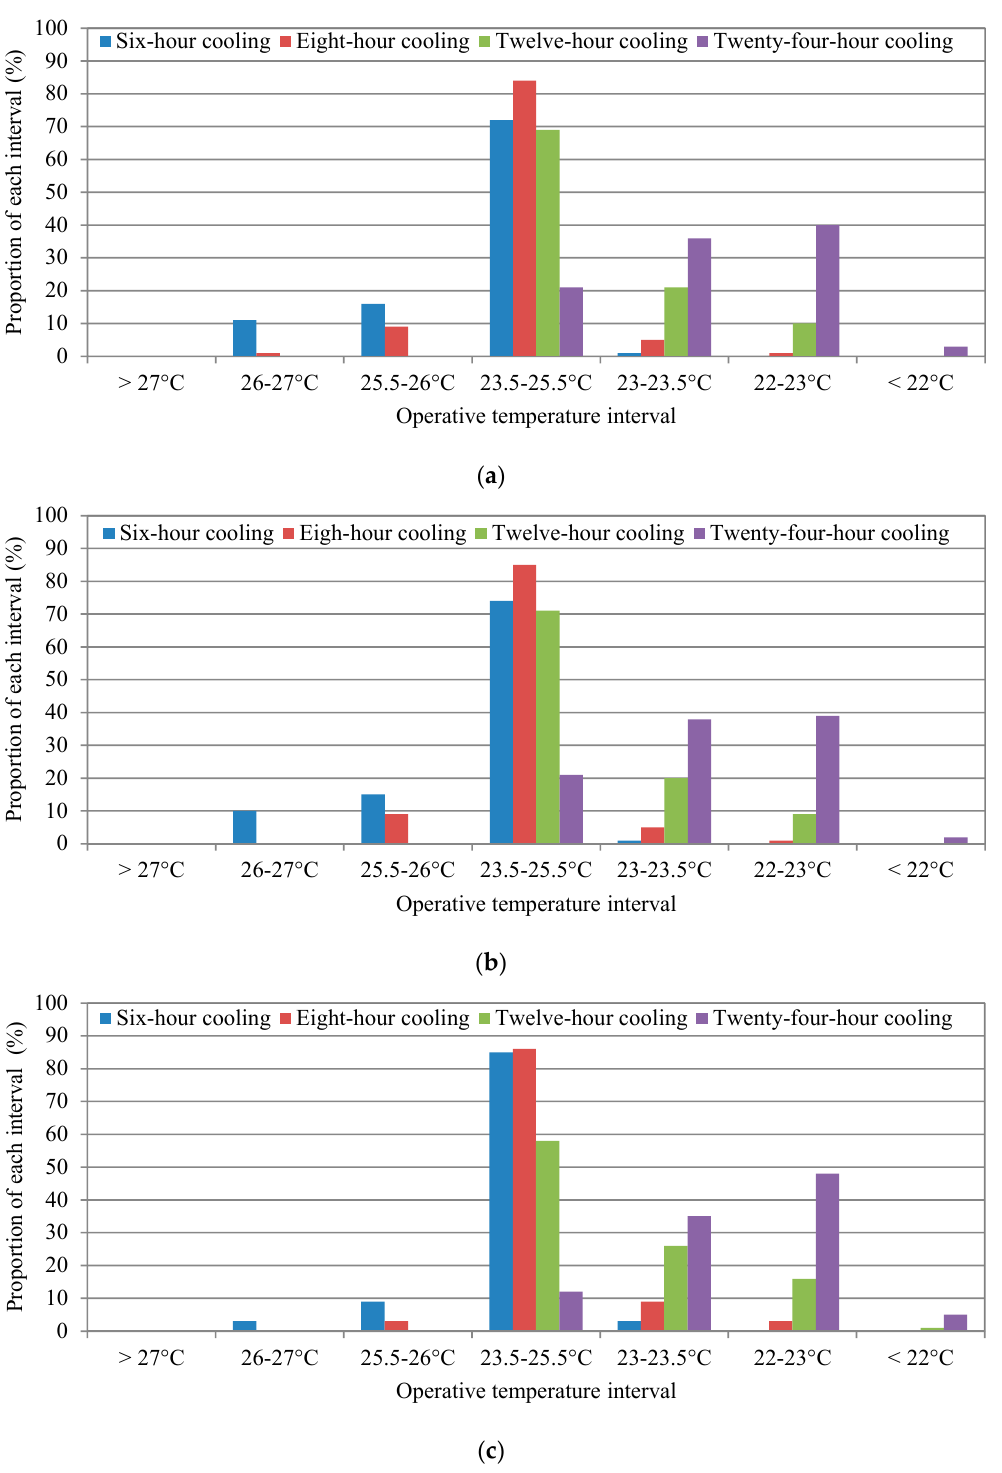
Figure 10. Proportions of time that different operative temperature intervals occur throughout the entire period of cooling under various cooling durations. ( a ) Top floor room; ( b ) second floor room; and ( c ) ground floor room.